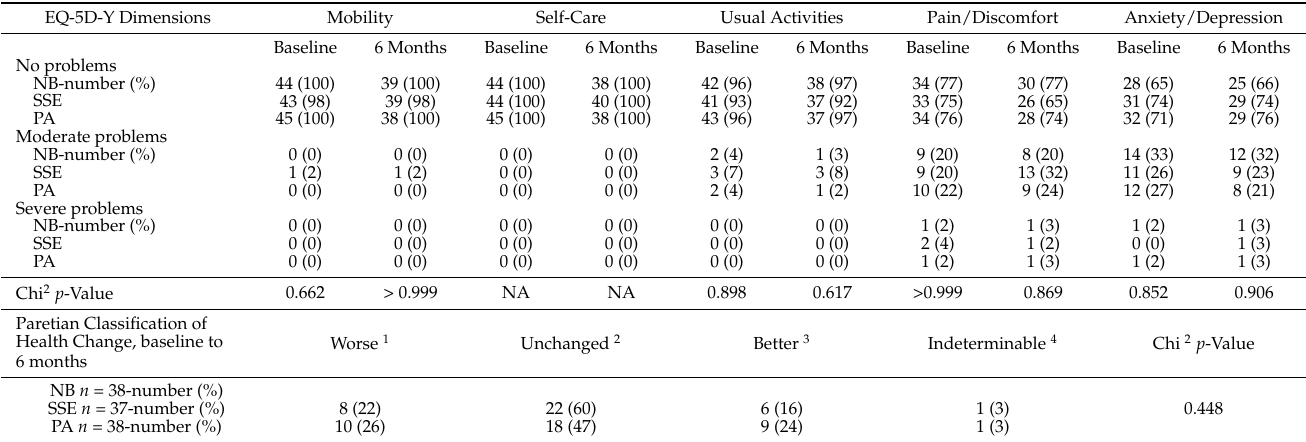
Table 6. Health-related quality of life for the EQ-5D-Y dimensions, at baseline and 6 months, and changes in health state according to Paretian Classification of Health Change from baseline to 6